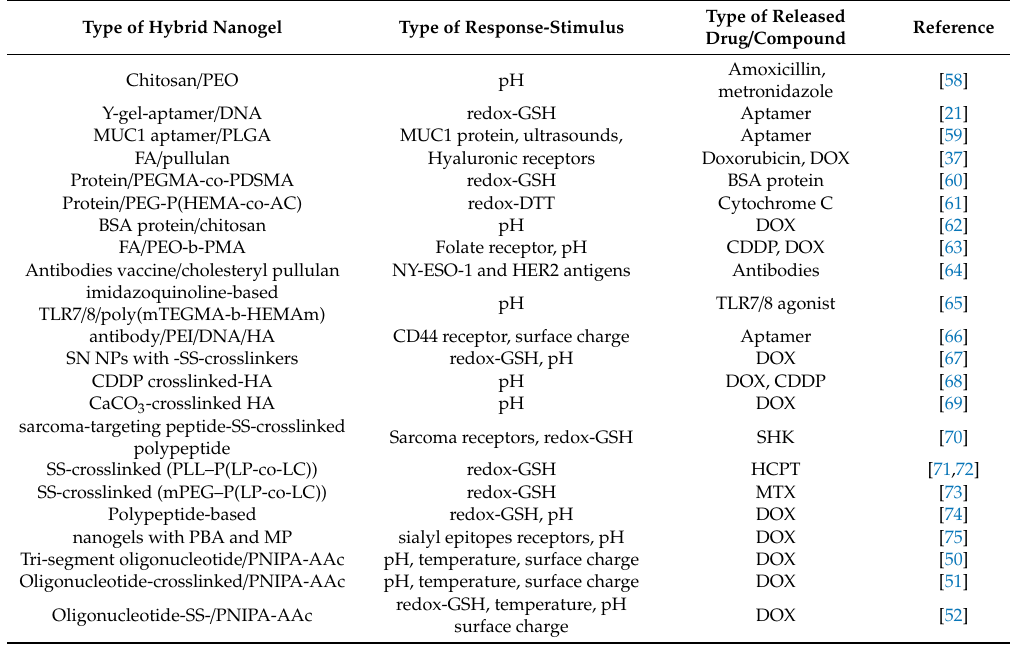
Table 1. Responsiveness of selected degradable hybrid